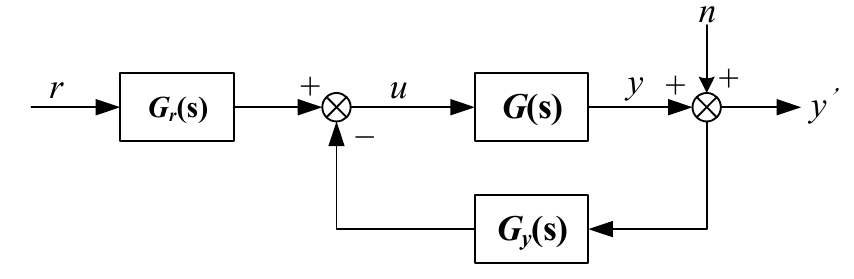
Figure 5. Block diagram of the system for ADRC.